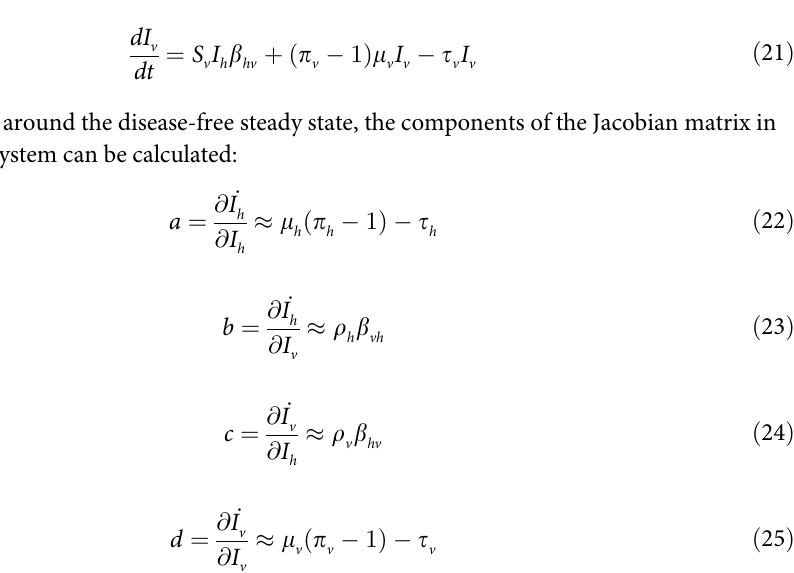
The full system of ODEs for the model framework are given in S2 Text, but the ODEs describing the numbers of infected hosts and vectors are as follows: